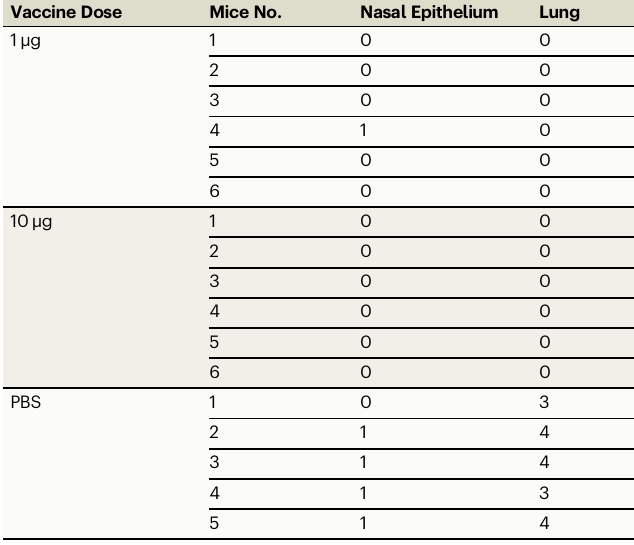
Table 1 | In-situ hybridization results of viral RNA in tissues Vaccine Dose Mice